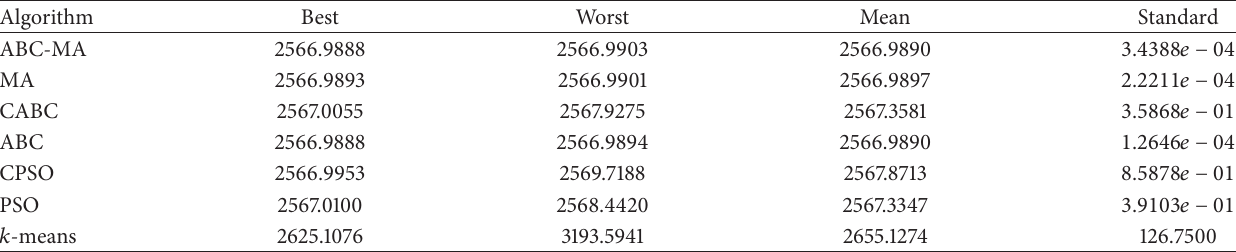
Table 9: Results obtained by the algorithms for 20 different runs on Haberman’s survival data.